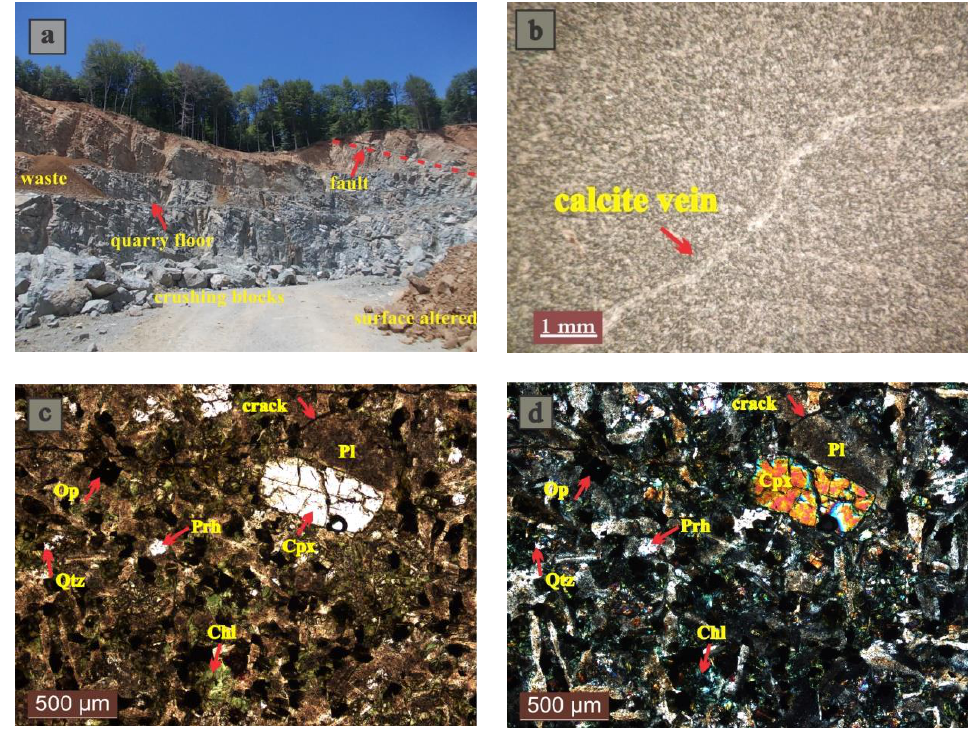
Figure 5. “Mrˇci´ci” quarry and petrographic properties of the dolerite DI-1 sample: ( a ) The head of the quarry; ( b ) macroscopic appearance with calcite veins; ( c ) microscopic image in ppl of a sample shows finely ophitic, ophitic and porphyritic texture intersecting with crack; ( d ) microscopic image of the same sample in xpl. Explanation: Chl—chlorite, Cpx—pyroxene, Op—opaque (metallic) mineral, Pl—plagioclase, Prh—prehnite,